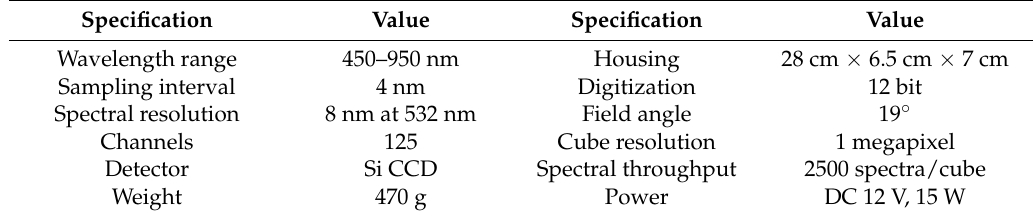
Table 1. Main parameters of the UHD 185 snapshot hyperspectral sensor (provided by the manufacturer). Specification Value Specification Value Wavelength range 450–950 nm Housing 28 cm × 6.5 cm × 7 cm Sampling interval 4 nm Digitization 12 bit Spectral resolution 8 nm at 532 nm Field angle 19 ◦ Channels 125 Cube resolution 1 megapixel Detector Si CCD Spectral throughput 2500 spectra/cube Weight 470 g Power DC 12 V, 15